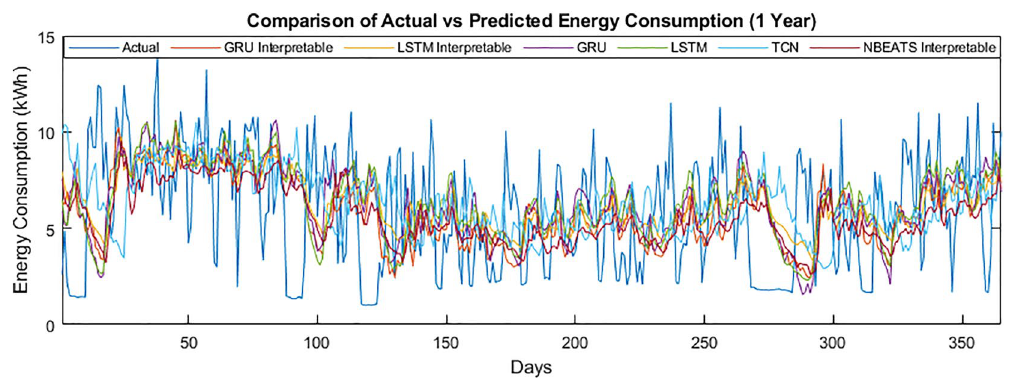
Figure 10. Comparison of actual vs predicted energy consumption (1